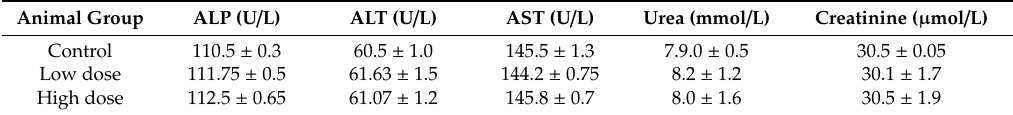
Table 4. Hepatic and renal function parameters of the test subjects (mean ± SD, n = 5). Animal